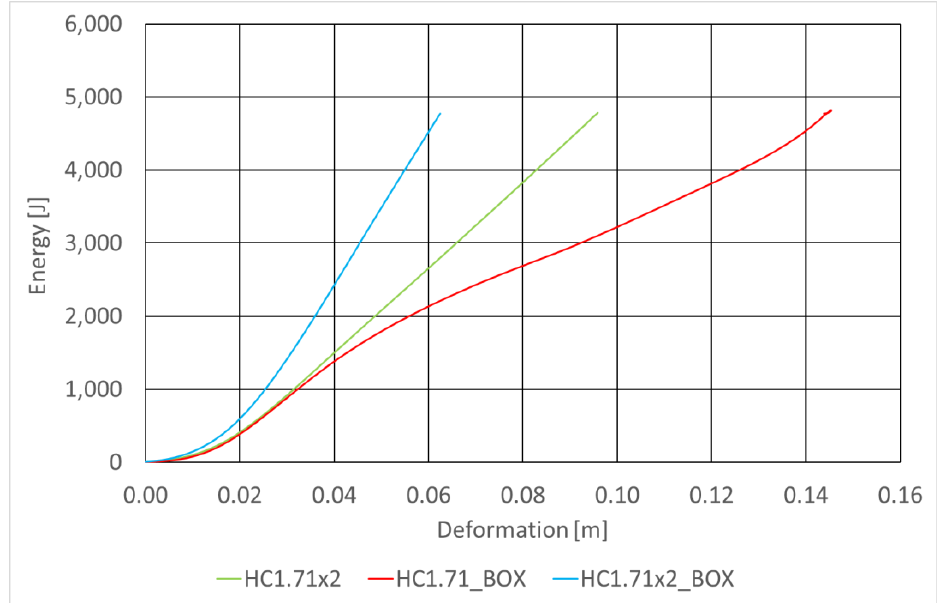
Figure 21. Comparison of the deformation values of the absorbers under test at the same impact energy.